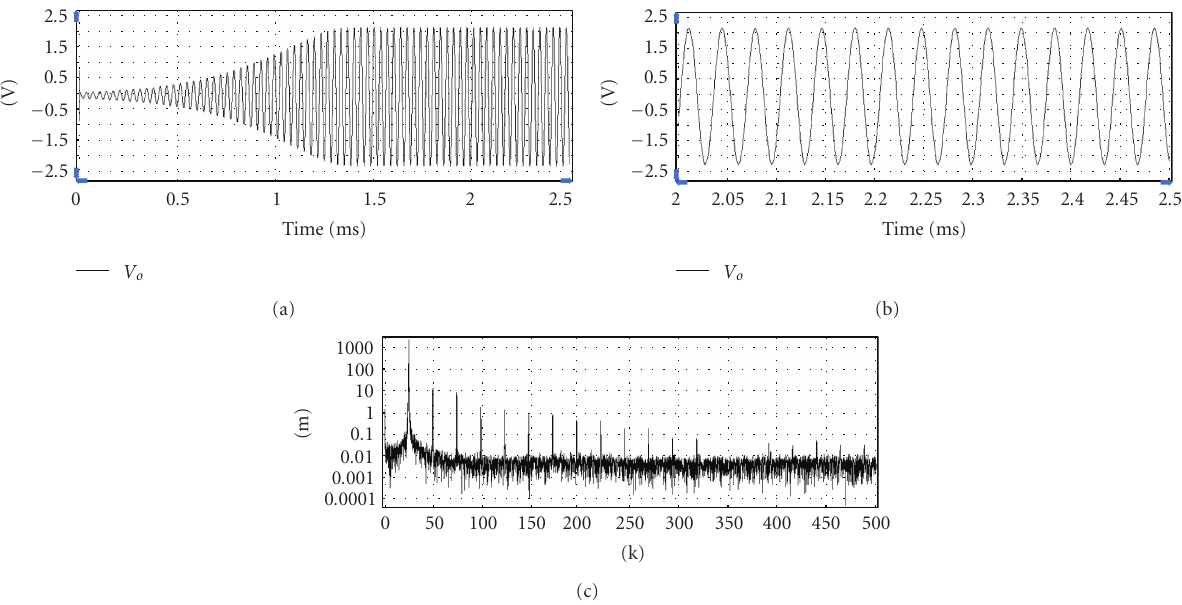
Figure 4: Oscillator in Figure 1(b): (a) startup of oscillations, (b) steady-state waveform, and (c) magnitude spectrum.